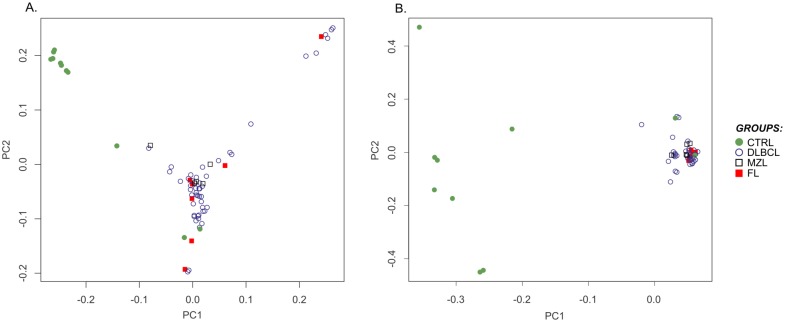
Principal components analysis on B-cell lymphomas versus controls panel.A. Samples distribution using all SNVs identified in the B-cell lymphomas (BCL) versus control panel. B. Samples distribution using only significant novel BCL-associated SNVs.